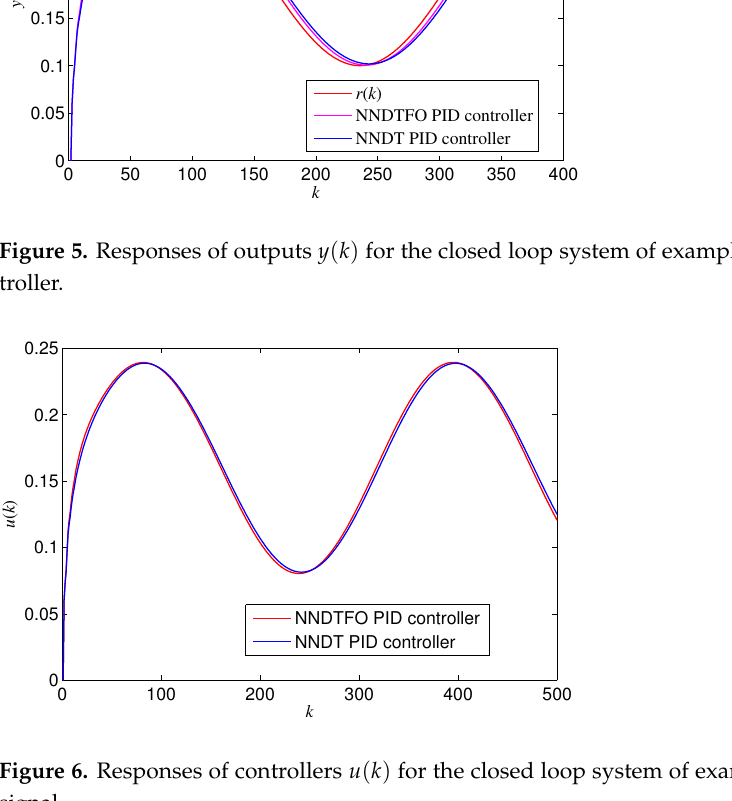
Figure 6. Responses of controllers u ( k ) for the closed loop system of example 1 with a sinusoidal